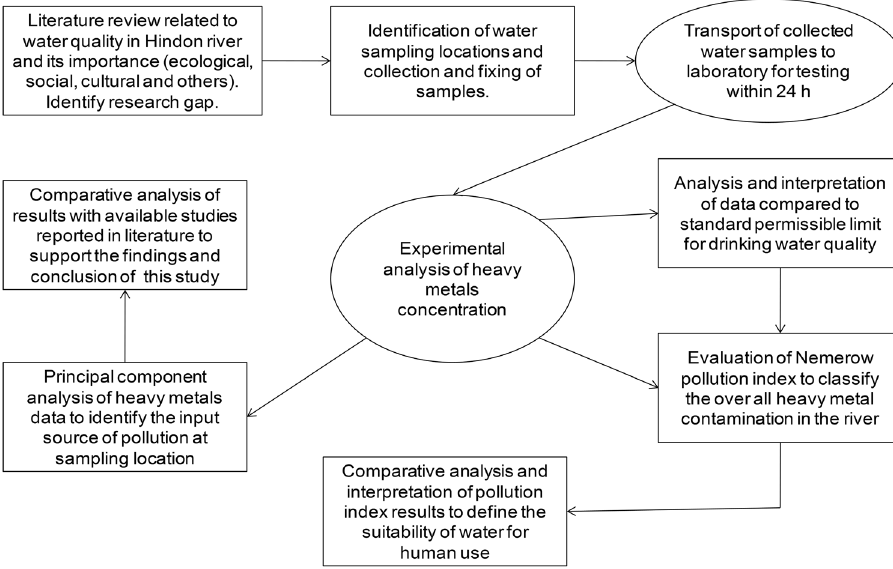
Fig. 2 Flow diagram of